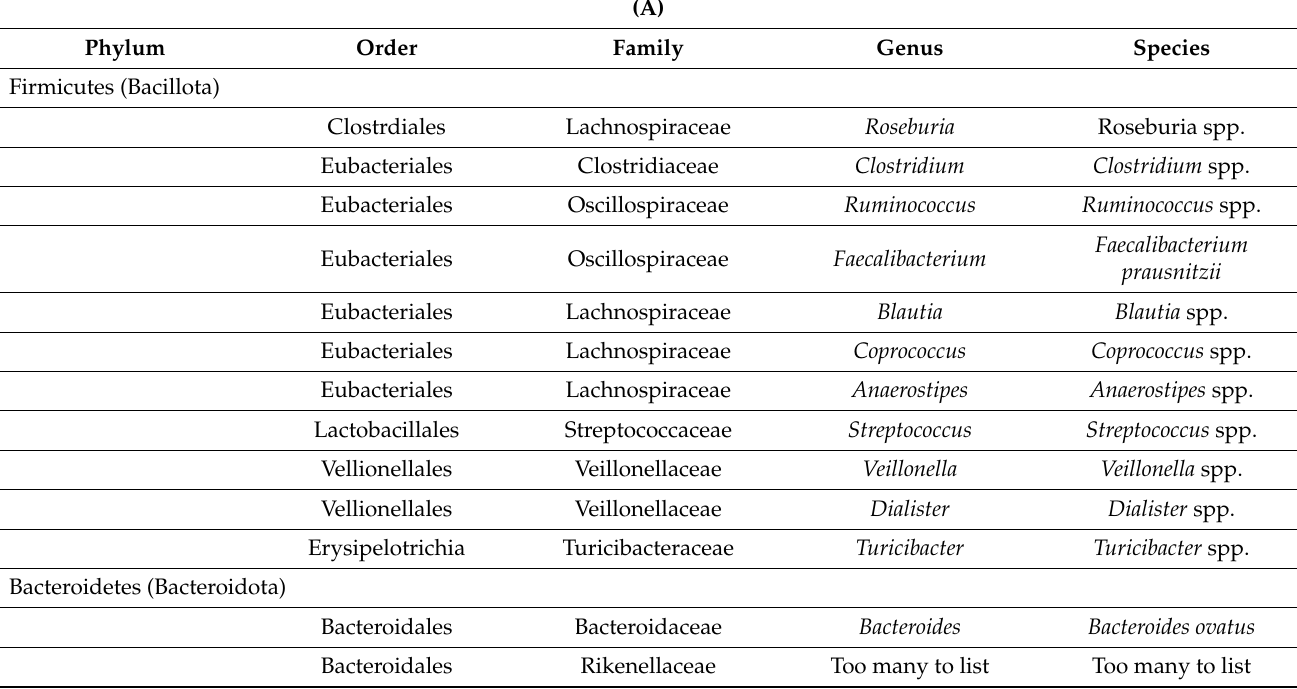
Table 1. Ig-Coated Bacterial Taxa Identified in Published Studies Employing Sequencing Methods. To be Included an Organism Needed to be Identified in Two Separate Studies. ( A ). Taxa Identified in Studies of Patients with Inflammatory Bowel Disease [32–38]. ( B ) . Taxa Identified in Studies of Patients with Dysbiosis Associated with a Variety of Other Causes